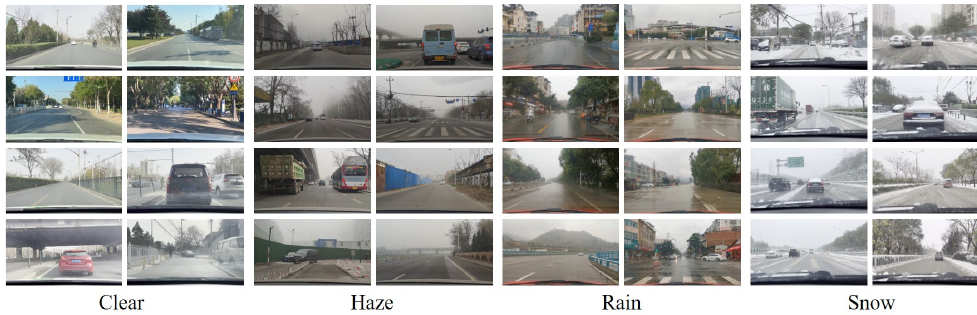
Figure 4. Sample scenes from the Realistic Driving Scenes under Bad Weather dataset